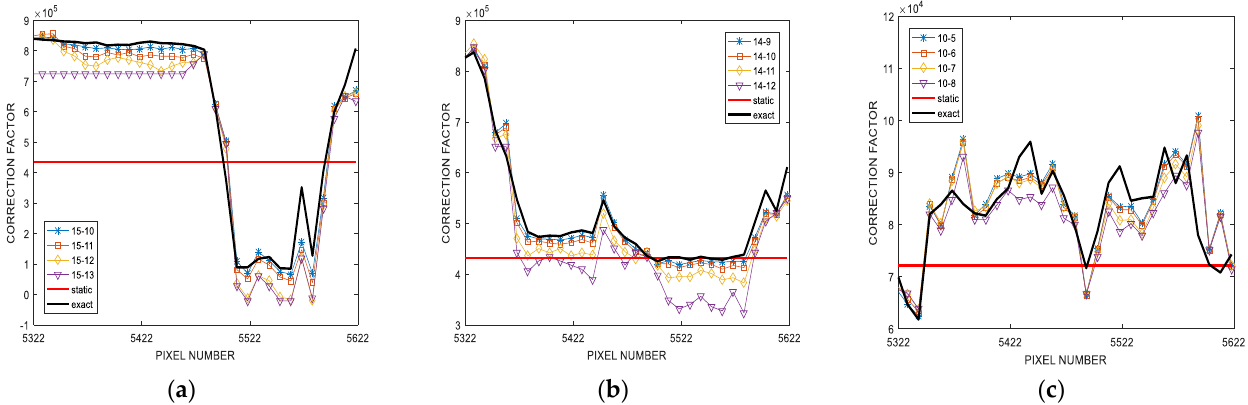
Figure 5. The correction factor updating process for a 7 × 7 convolution applied on the airplane benchmark: ( a ) N T 1 = 15, ( b ) N T 1 = 14, ( c ) N T 1 = 10.